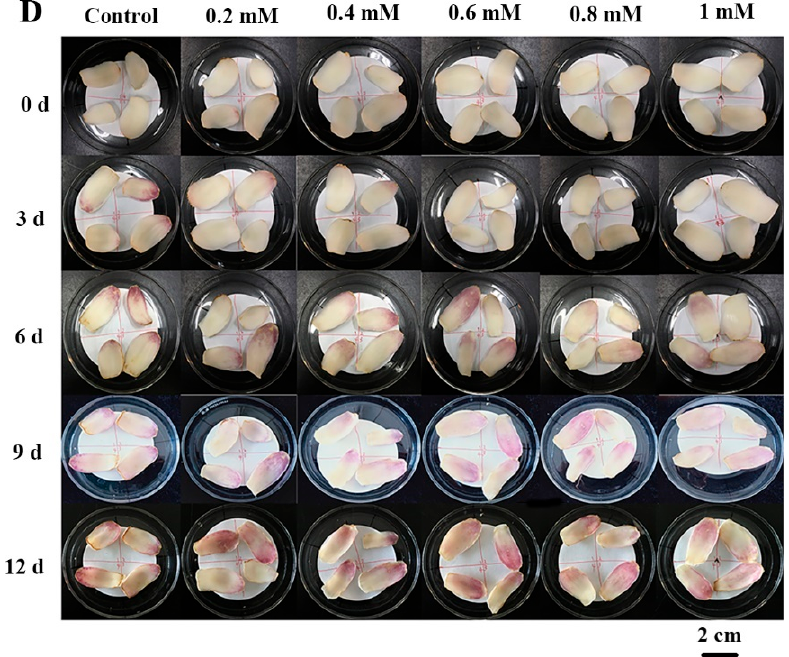
Figure 1. Changes in the fresh weight rate ( A ), scales grades ( B ), storage life ( C ) and phenotype ( D ) of Lanzhou lily scales fumigated with different concentrations of NaHS at room temperature. The concentrations of NaHS were 0, 0.2, 0.4, 0.6, 0.8, and 1 mM. The error bars denote the standard errors ( n = 3). The different letters above the bars in Figure 1C indicate significant differences ( p < 0.05) according to one-way ANOVA and Duncan’s multiple range test. d: days.